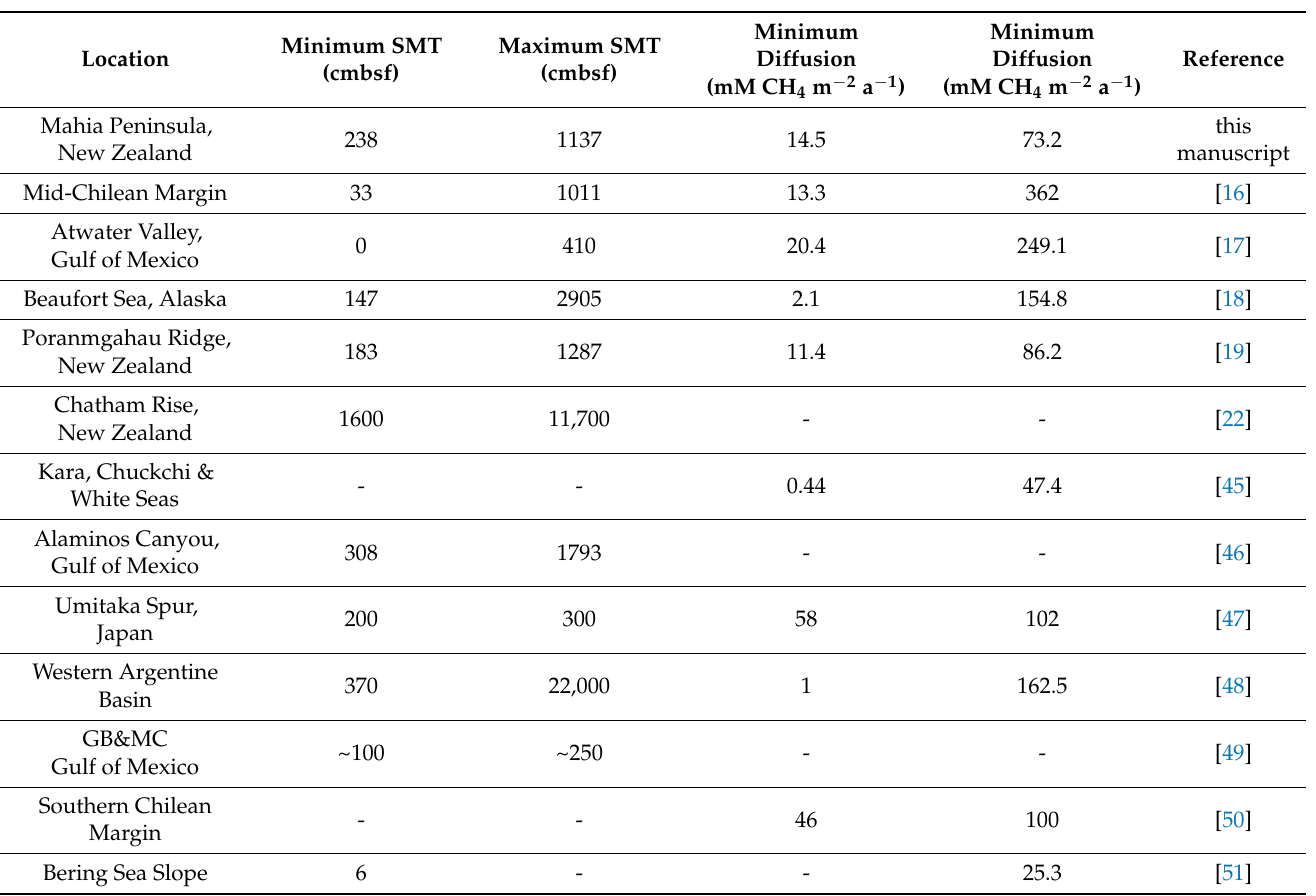
Table 1. An overview of published literature for sediment vertical CH 4 migration and the sulfate– methane transition depth. This provides a global data summary for comparison to this work on the Mahia